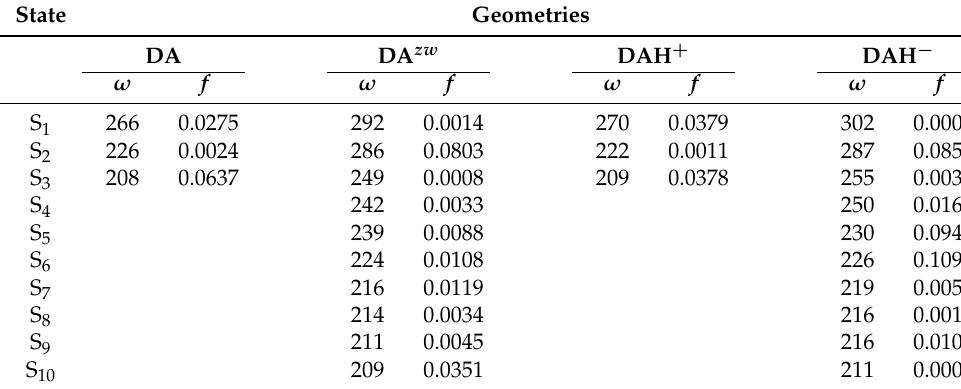
Table 1. Vertical electronic transitions (in nm) and their oscillator strengths in the spectral range of 200–300 nm found for the DA, DA zw , DAH + , and DAH − equilibrium geometries obtained at